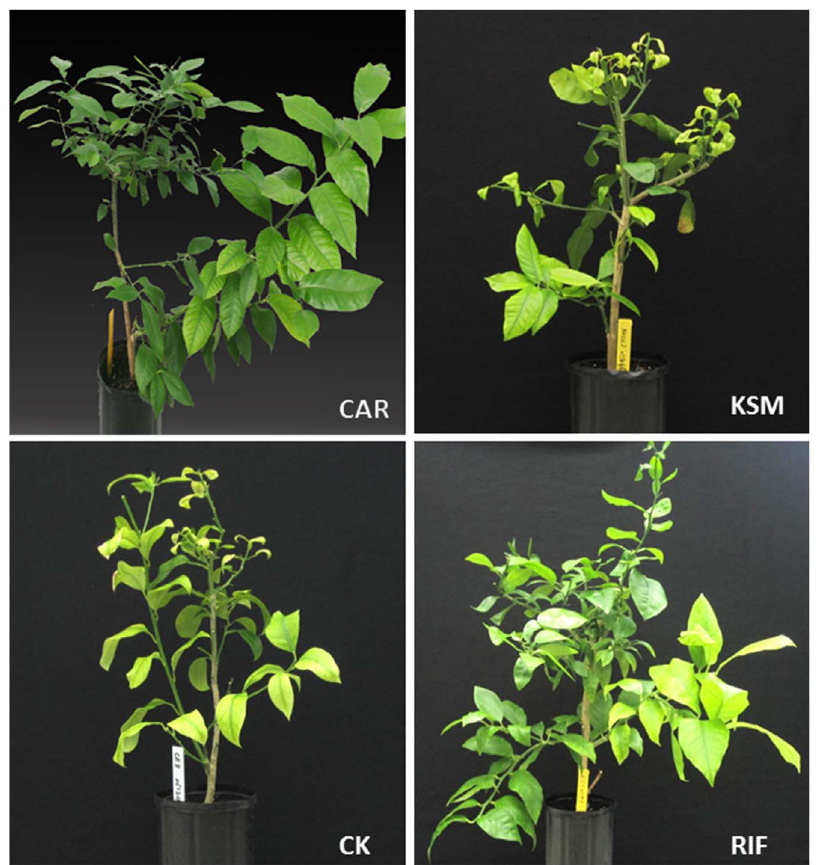
Figure 1. Huanglongbing (HLB)-affected grapefruit (‘Duncan’) plants with graft-inoculation of Las-infected lemon scions treated with different antibiotics. I-CAR : Highly effective compounds; II-RIF : Partly effective compounds; III-KSM : non-effective compounds; CK : water control. Photograph was taken 6 months after graft inoculation. Typical HLB symptom of leaf curl and corky veins on grapefruit rootstock and blotchy mottle or yellow shoots on leaves of lemon scion were apparent.